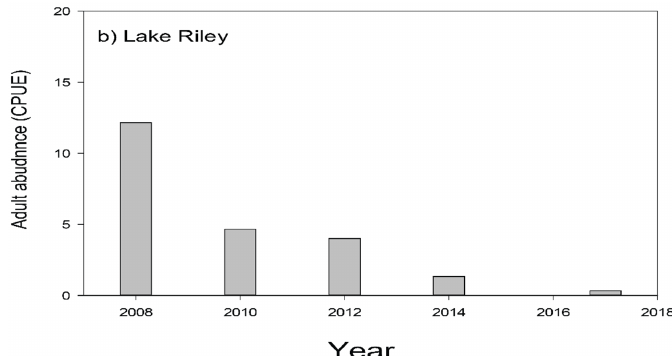
Figure 8. Adult carp CPUE (carp / h) as monitored by boat electrofishing in: ( a ) Lake Susan, and ( b ) Lake Riley. Fishes 2020 , 5 , x FOR PEER REVIEW